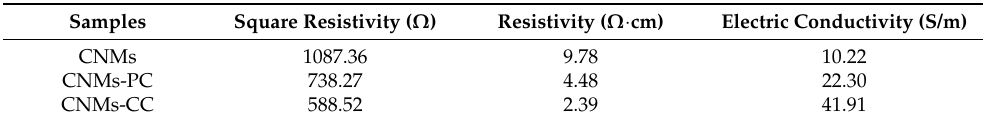
Table 1. The Resistivity and electrical conductivity of samples.